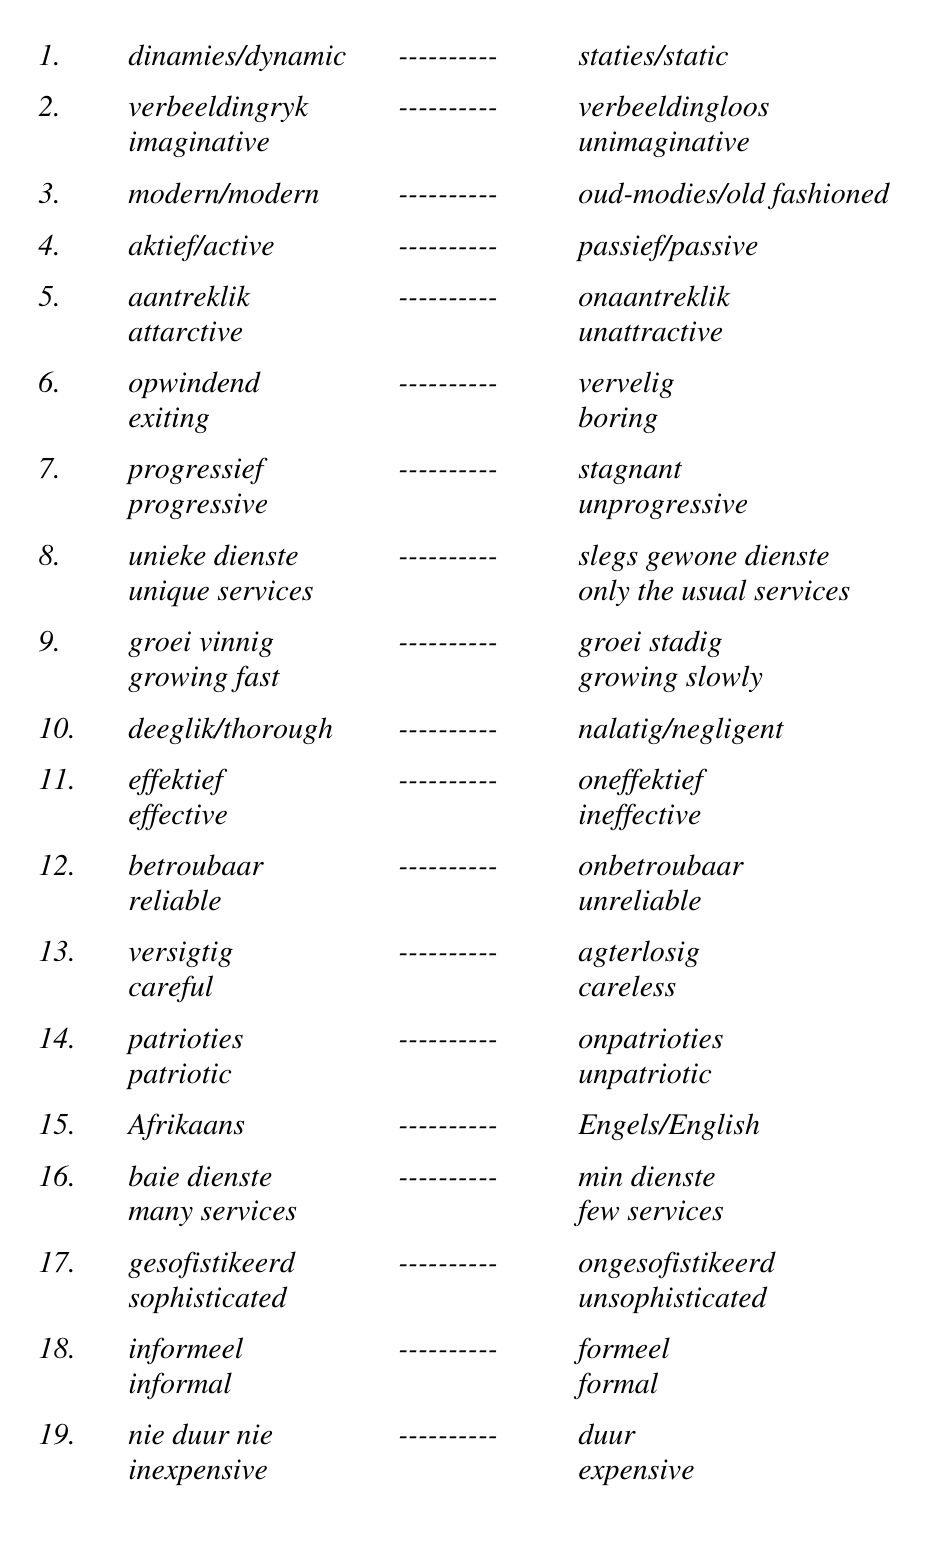
Figuur 1. Lys van skale in finale vraelys